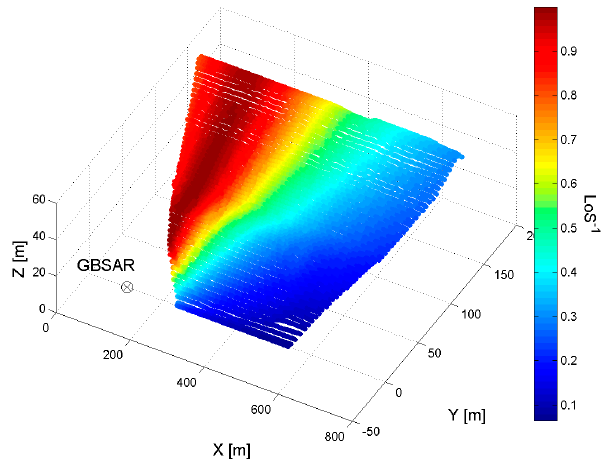
Figure 2. ( a ) Range distance R ; ( b ) azimuth angle ψ ; ( c ) vertical angle ξ .